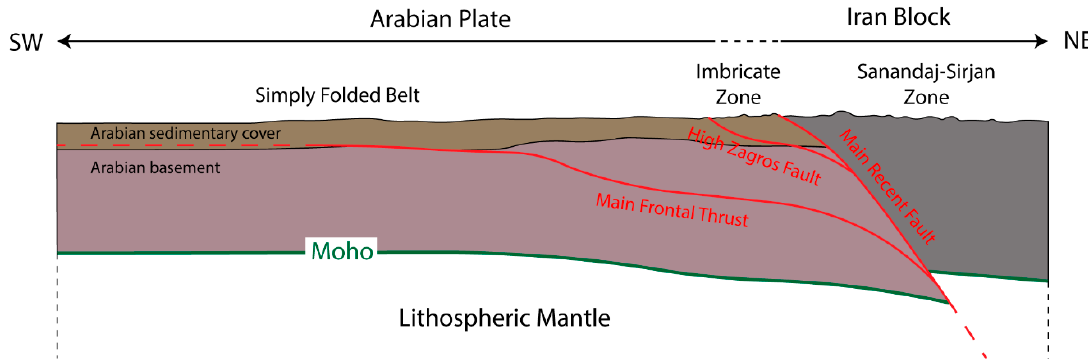
Figure 2. Representative cross-section showing the main tectonic features of the Lurestan arc, which sketch map is shown in Figure 3. The thickness of the Arabian sedimentary cover and Arabian basement are defined in Section 3.2. The Moho discontinuity used for the analytical procedure is 3-D represented in Figures 4 and 5.